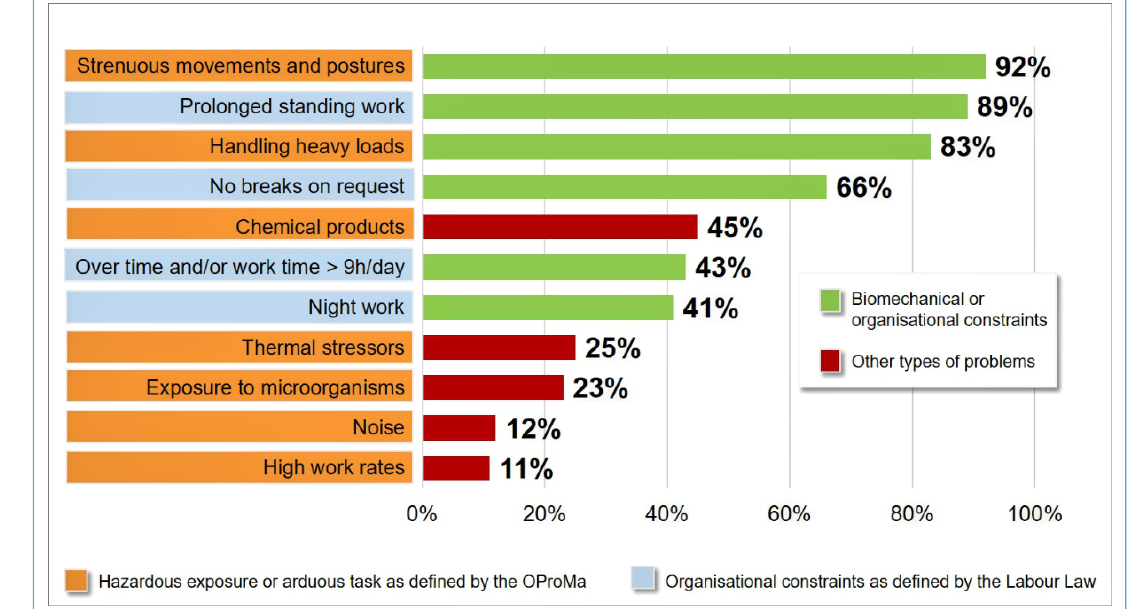
Figure 3: Percentages of pregnant employees faced with occupational exposures as defined by the OProMa and the Federal Labour